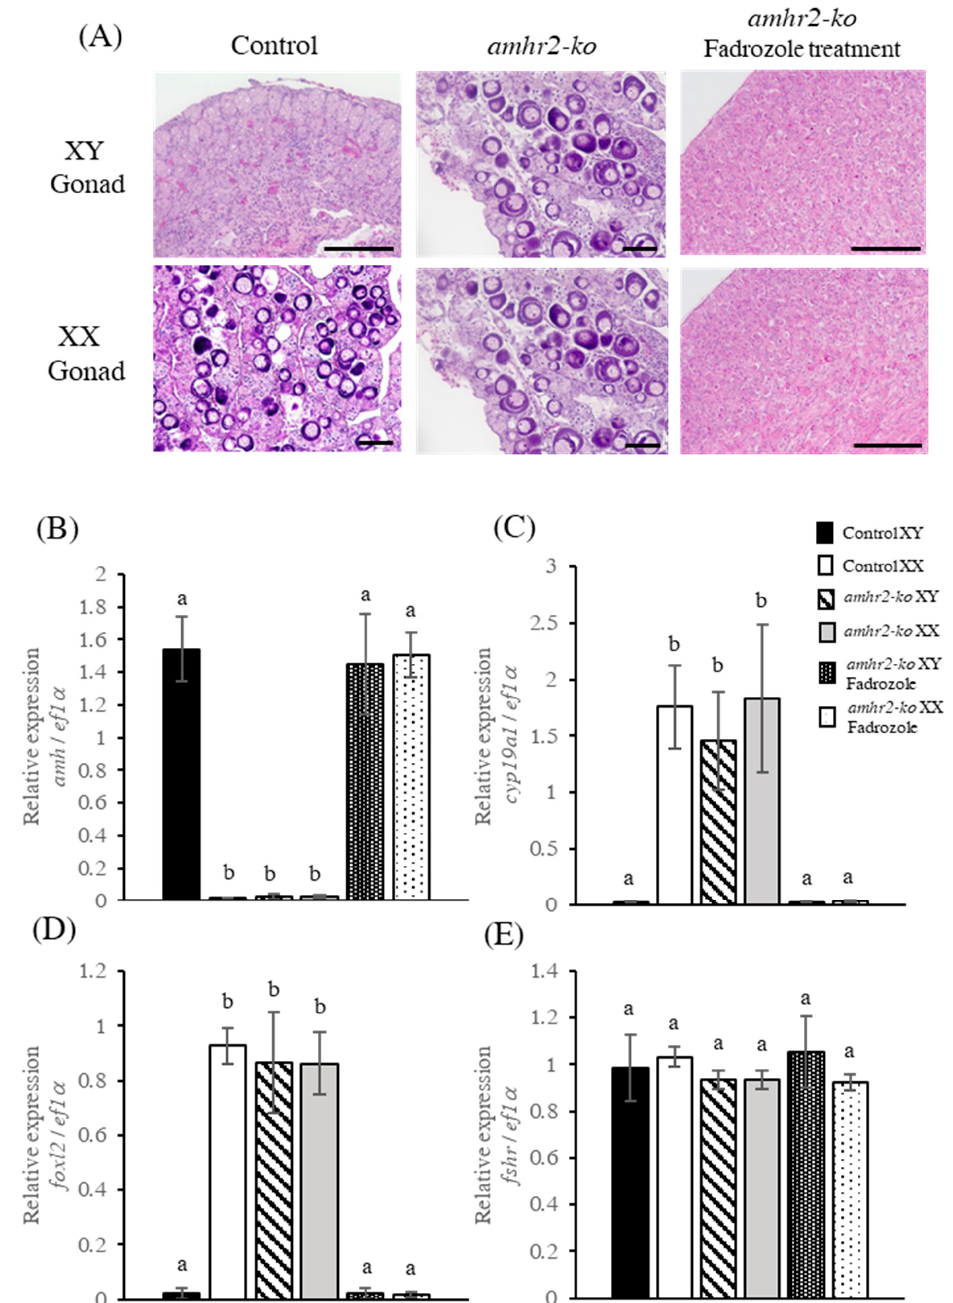
Figure 4. Phenotypic analysis of amhr2 knockout mutants treated with the aromatase inhibitor fadrozole. Histological images of gonads from control fish, amhr2 mutants, and fadrozole-treated amhr2 mutants at 200 dah ( A ). Scale bar, 100 µ m. Real-time PCR analyses of amh ( B ), cyp19a1 ( C ), foxl2 ( D ), and fshr ( E ) expressions were carried out using the gonads of the flounder at 200 dah. Different letters denote significant differences at p < 0.01.